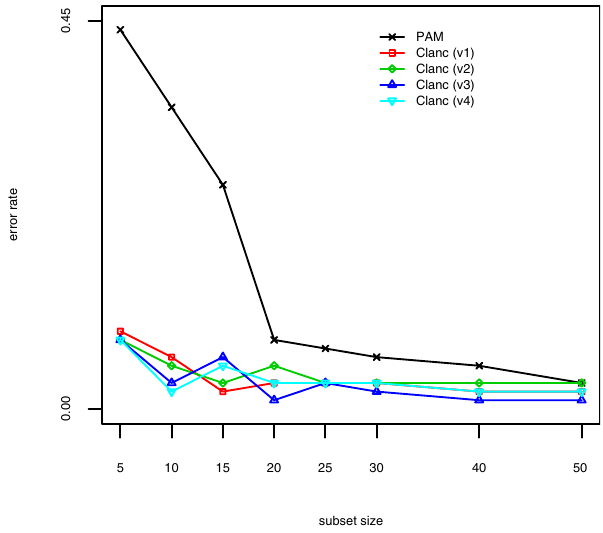
Figure 1. Results for SRBCT data. Classifiers are identical to those in Tables 3 and 4, with Clanc v1-v4 corresponding to the last four variants reported there, respectively. doi:10.1371/journal.pone.0001002.g001 on 2,307 genes in 83 SRBCT samples. The tumors were classified as Burkitt lymphoma, Ewing sarcoma, neuroblastoma, or rhabdomyosarcoma. There are 11, 29, 18, and 25 samples in each respective class. In the second example, expression measure- ments were made on 4,026 genes in 58 lymphoma patients [21]. The tumors were classified as diffuse large B-cell lymphoma and leukemia, follicular lymphoma, and chronic lymphocytic leuke- mia. There are 42, 6, and 10 samples in each respective class. The third example involves the cell lines used in the National Cancer Institute’s screen for anti-cancer drugs [22]. Expression measure- ments were made on 6,830 genes in 60 cell tumors. There are representative cell lines for each of lung cancer, prostate cancer,